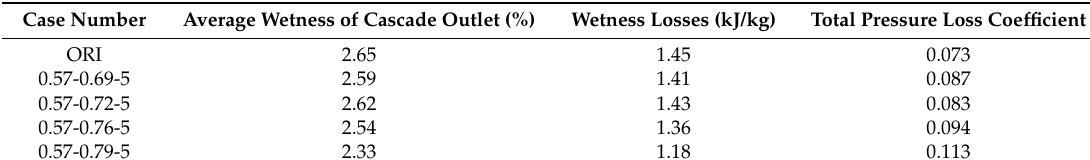
Table 1. Parameters related to suction surface.